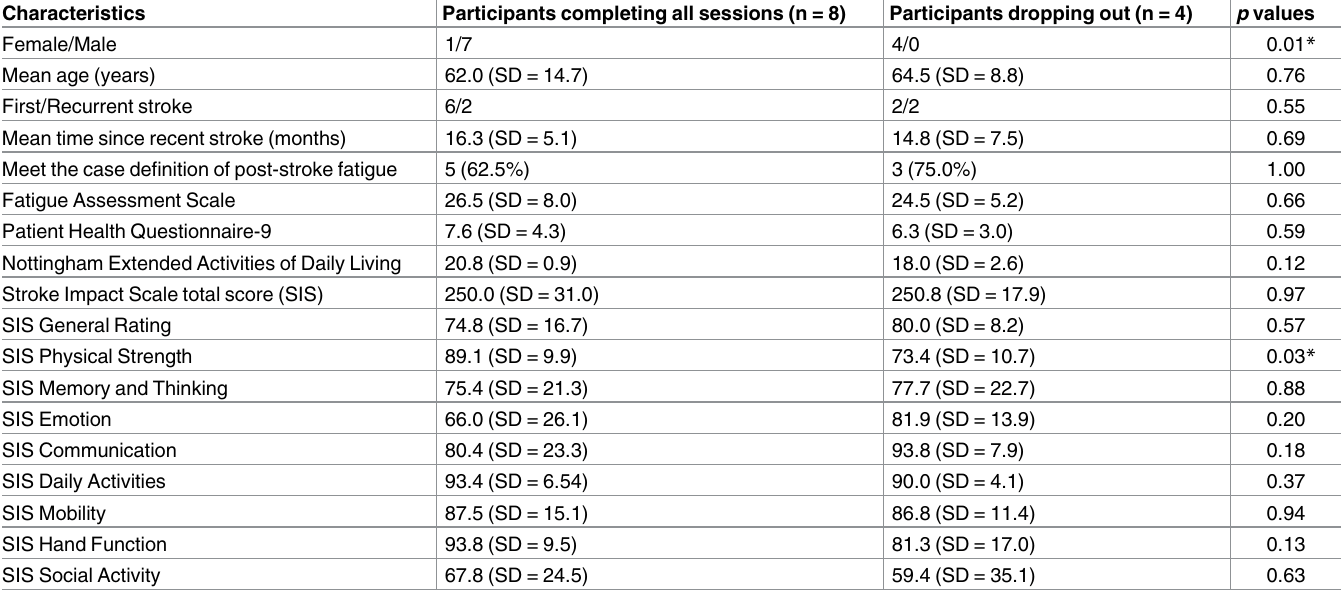
Table 2. Clinical characteristics of participants at recruitment.